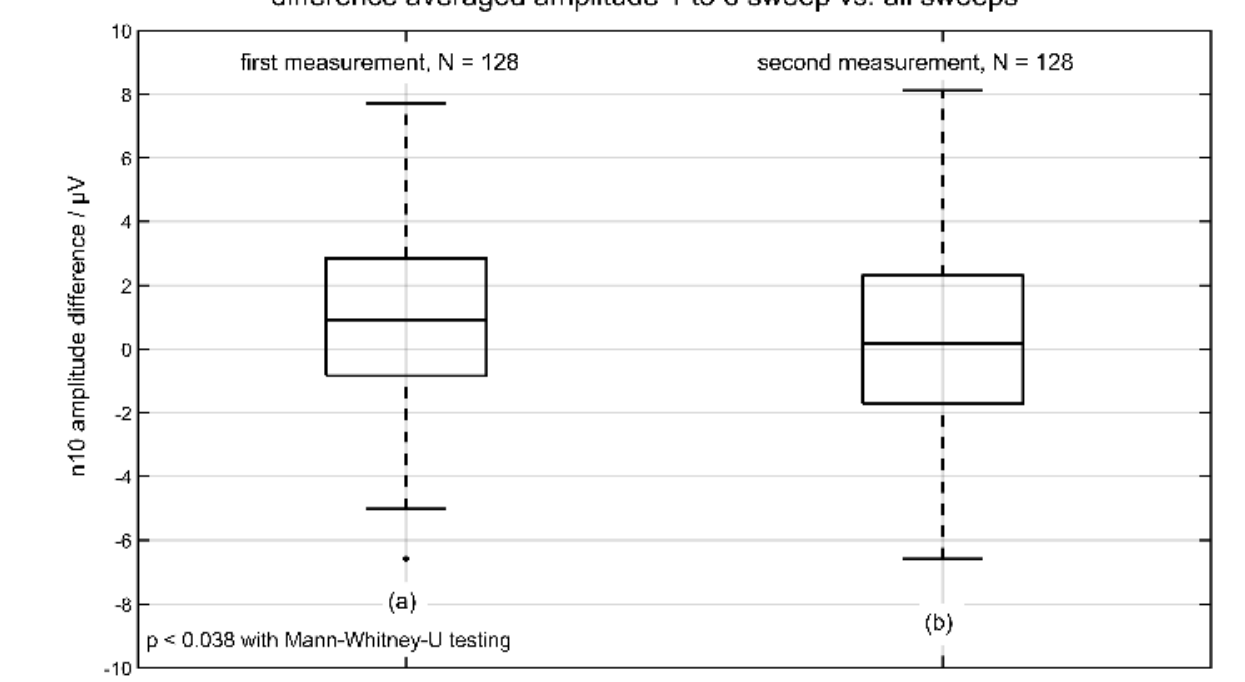
Figure 2. Differences in averaged n10 amplitude (sweeps 1 to 6 vs. all sweeps). The result of the first measurement is depicted in ( a ) and the result of the second measurement is shown in ( b ).